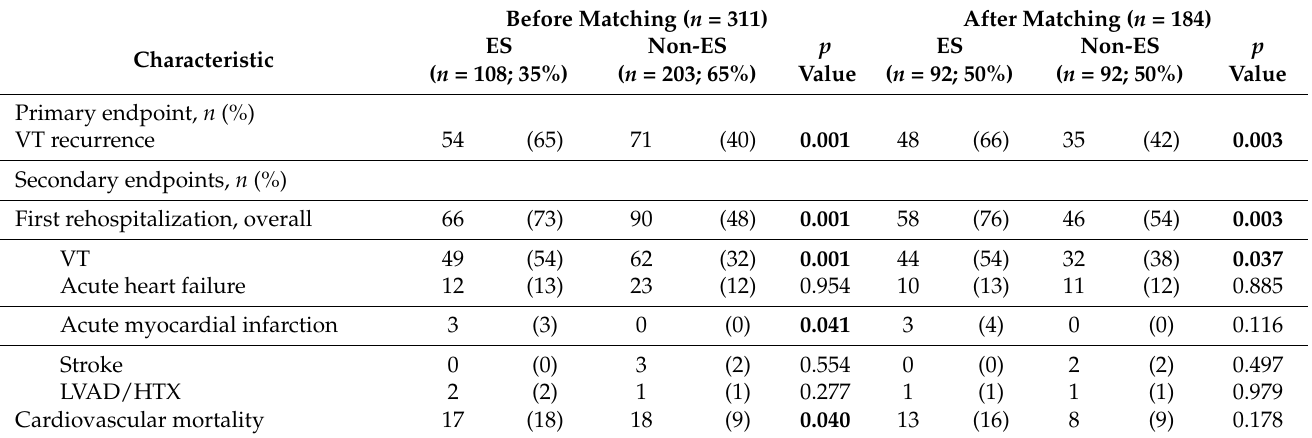
Table 4. Primary and secondary endpoints.